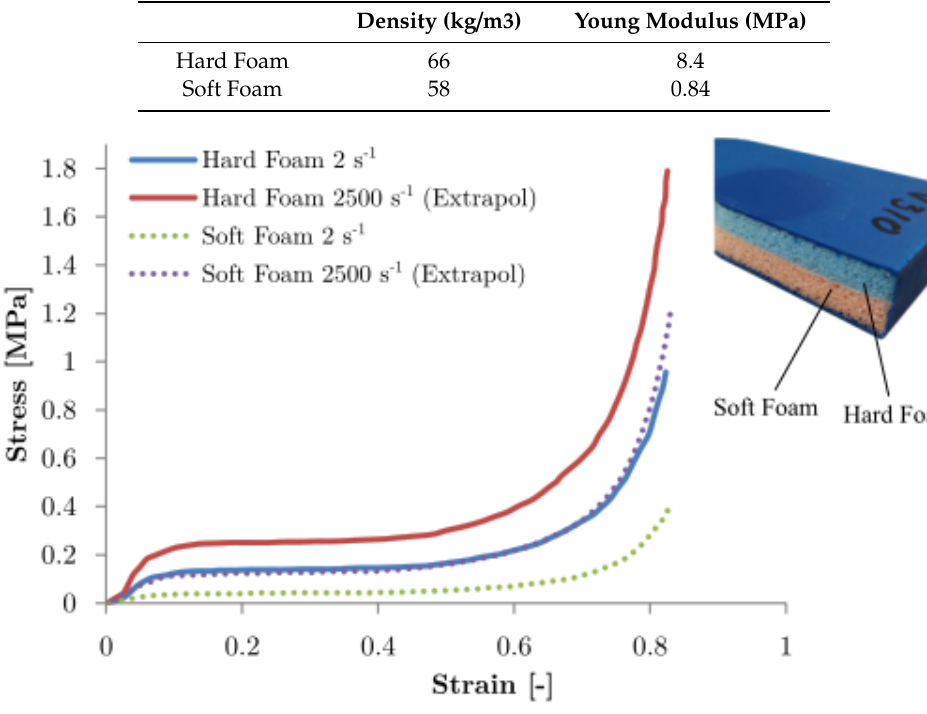
Figure 3. Stress–strain curves for both inner foams.